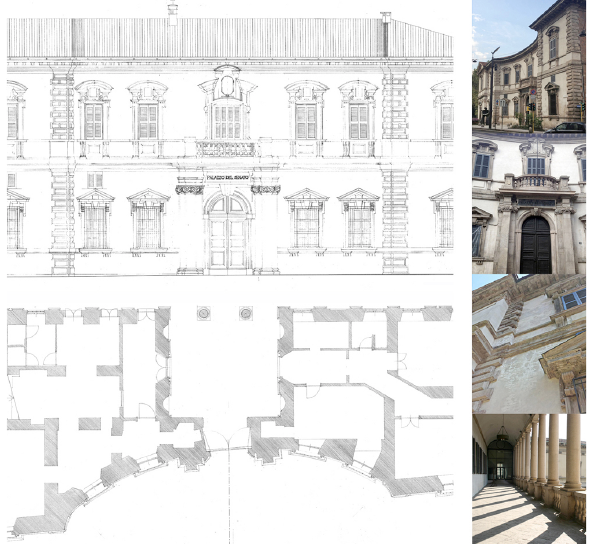
Figure 7 – Architectural Survey of the Senate Palace in Milan,